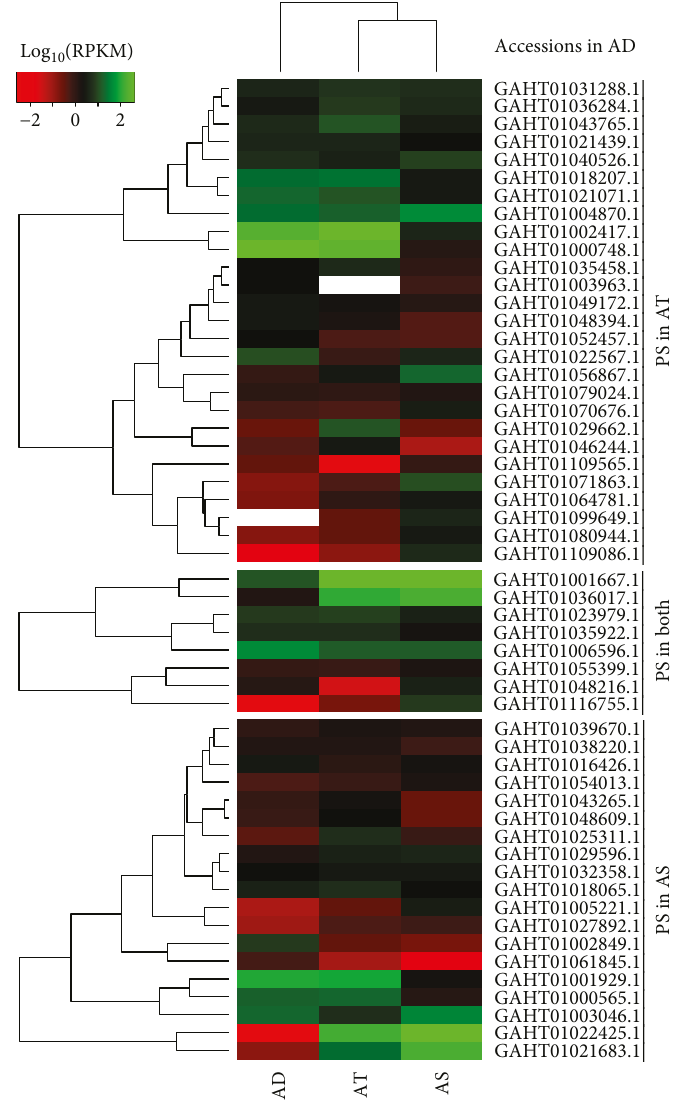
Figure 5: In silico expression pattern of positive selection (PS) unigenes in Agave leaves. Rows and columns in heat maps represent genes and Agave species. Species name of A. deserti (AD), A. tequilana (AT), and A. sisalana (AS) is shown under the heat maps. The colour bar at the top indicates the degree of expression: red — low expression; green — high